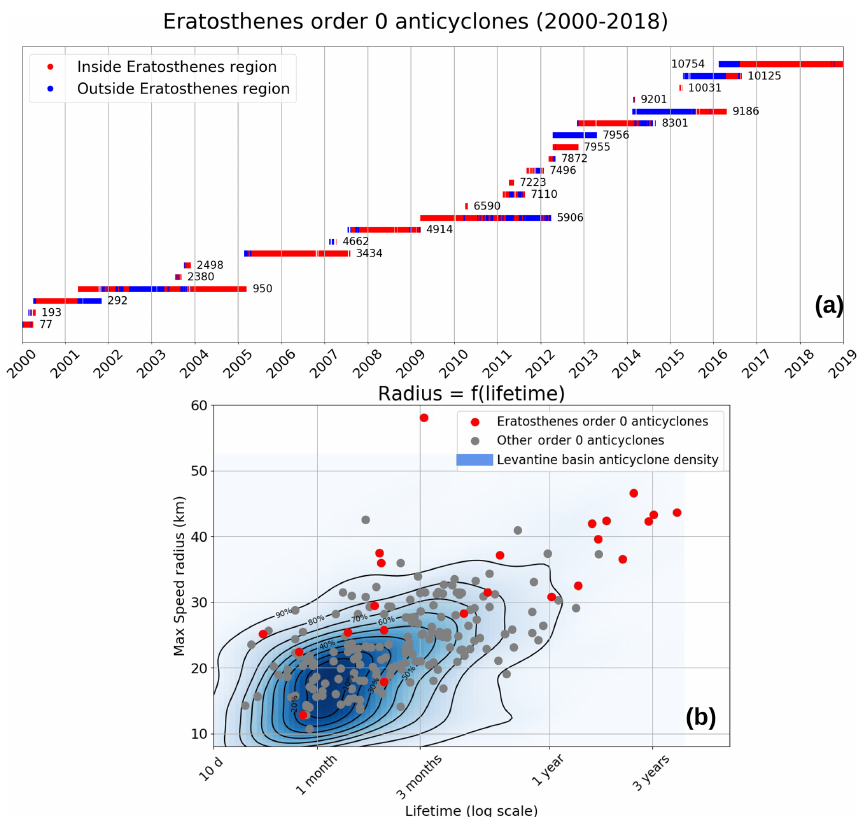
Figure 8. Details of the anticyclones constituting the EAA, detected as order 0 for the Eratosthenes region (tracks in Fig. 2a). (a) Time series with the eddy ID number from the DYNED database. The colored marker indicates when the eddy center is within (red) or outside of (blue) the region. (b) Scatterplot of the maximum speed radius as a function of lifetime, on a logarithmic scale, for order 0 anticyclones of the Eratosthenes region (red dots) and the other regions (gray dots); the blue shaded background is the density function for all LB anticyclones – except the Eratosthenes anticyclones – with contours each 10% probability